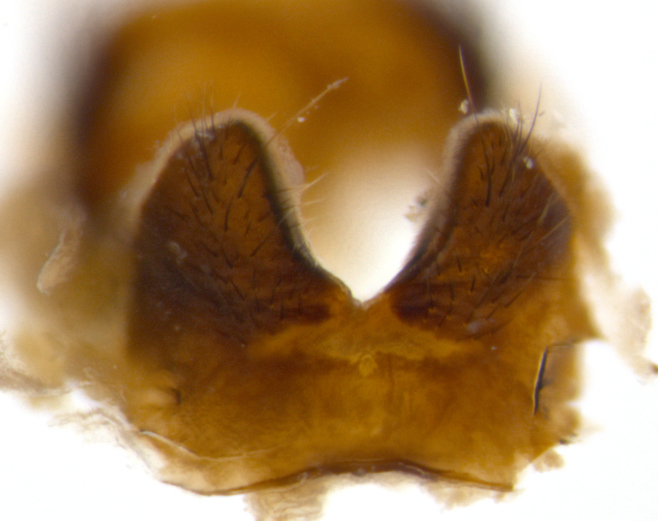
sternite 5, ventral view